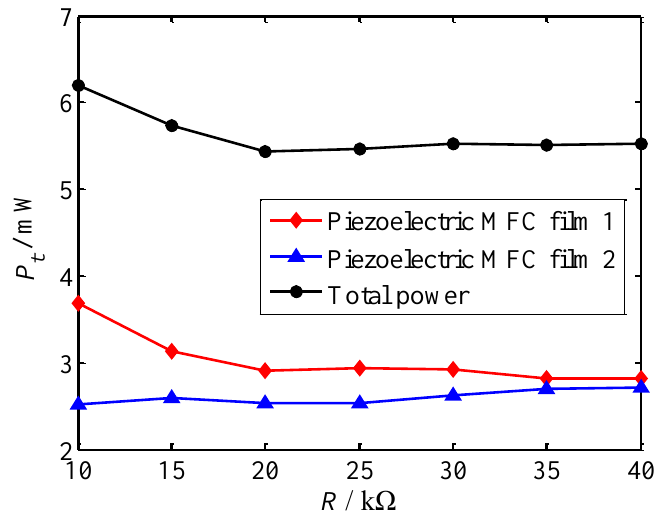
Figure 8. Output power varies with load resistance under transient excitation.